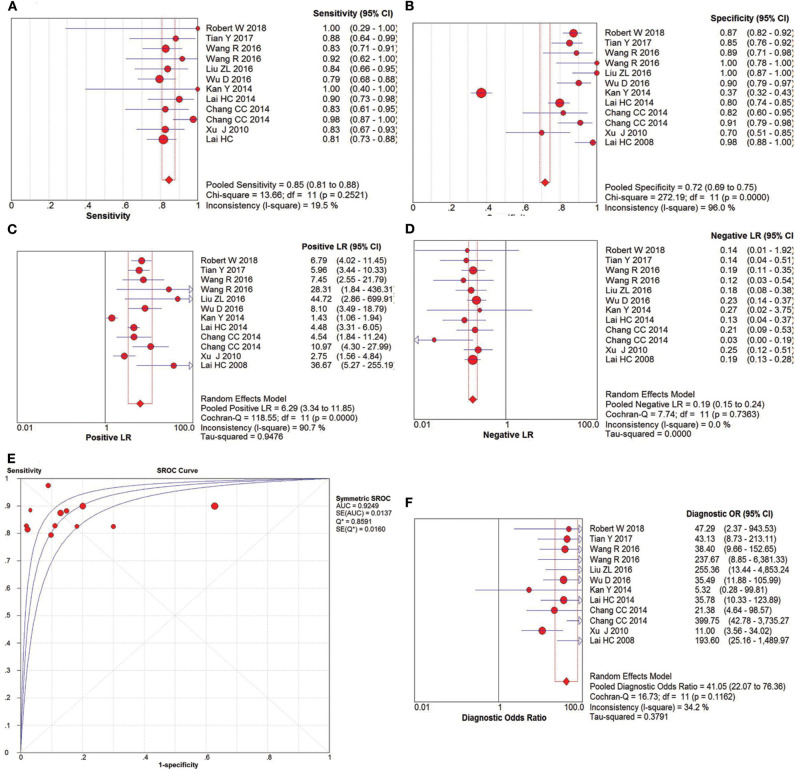
SROC curve (E) and forest plots of sensitivity (A), specificity (B), positive-likelihood ratio (PLR) (C), negative-likelihood ratio (NLR) (D) and diagnostic odds ratio (DOR) (F) of SOX1 hypermethylation in the diagnosis of CIN3+.